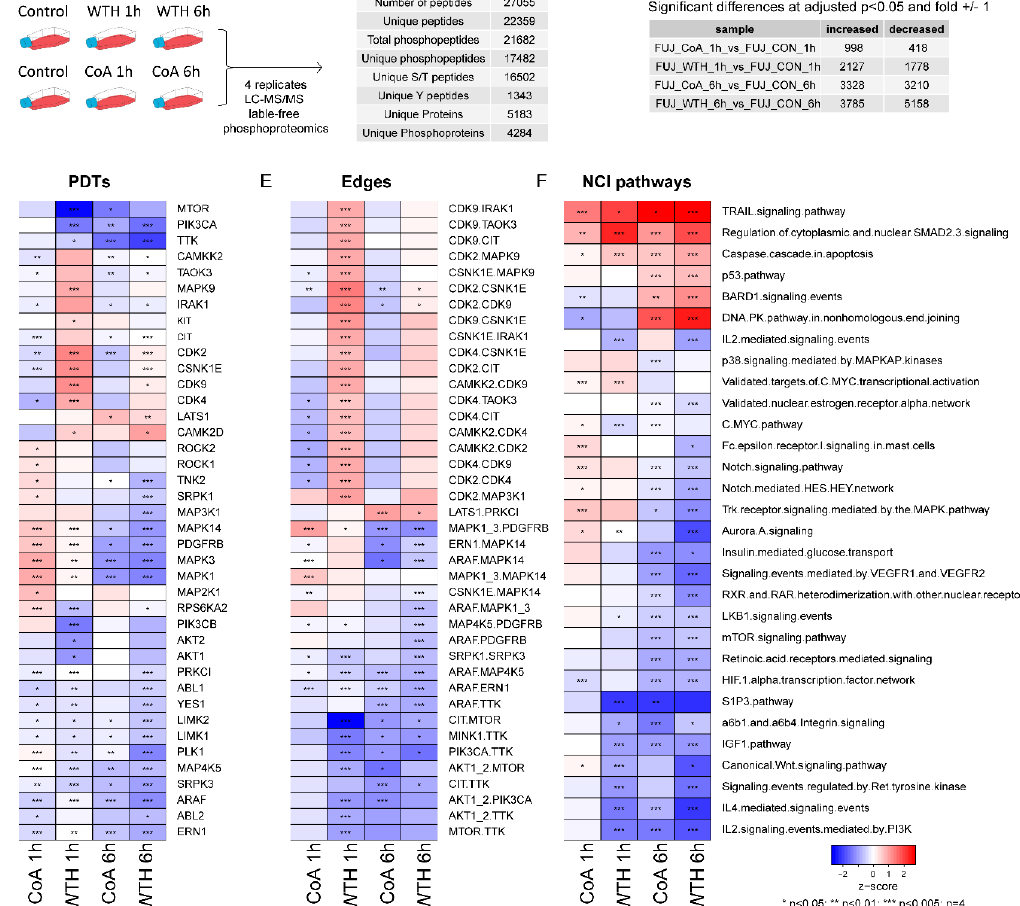
Figure 5. Phosphoproteomic analysis of withanolide-treated cells. ( A ) Experimental design. ( B ) Summary of quantitative data. ( C ) Number of phosphopeptides changes induced by WTH and